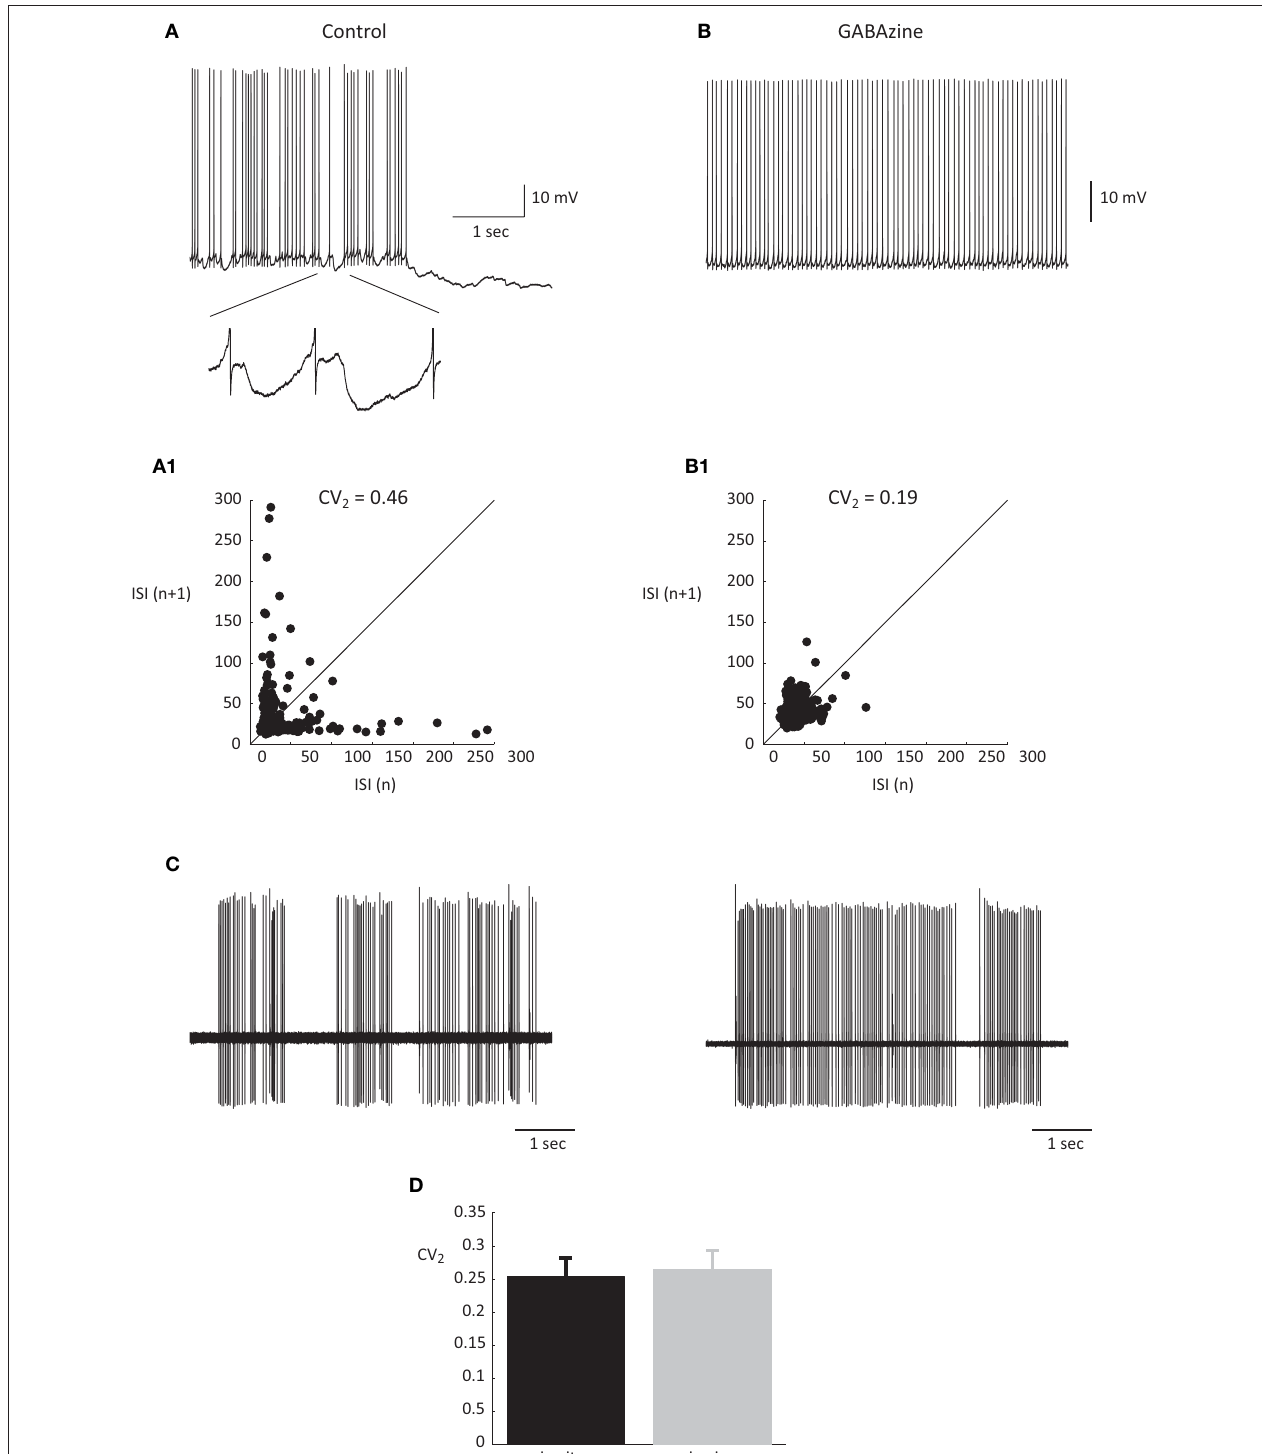
before (A1) and after (B1) GABAzine application constructed from 2 min of recordings of the same cells as in (A) and (B) . (C) Two extreme examples of the most non-regular (left) and the most regular (right) units that were recorded in an anesthetized rat in vivo . (D) The average CV in vitro and in vivo n = 12 and 6,